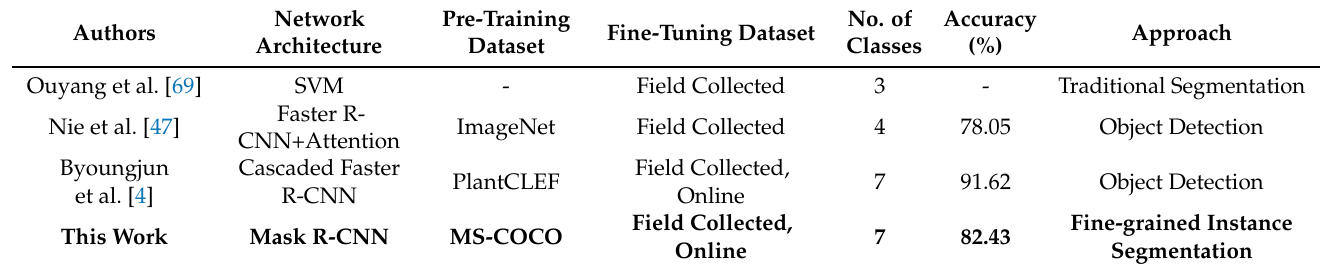
Table 11. A comparison with relevant